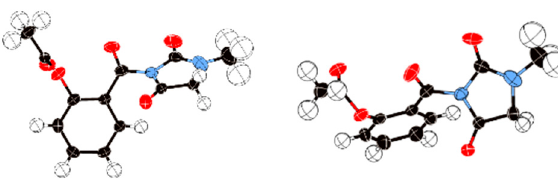
Figure 4. X ‐ ray single crystal analysis. Left: Chemical structure of 2 . Middle: Top view of the X ‐ ray single crystal structure. Right: Side view. Oak Ridge thermal ellipsoid plot program (ORTEP) for crystal structure represents 50% possibility.